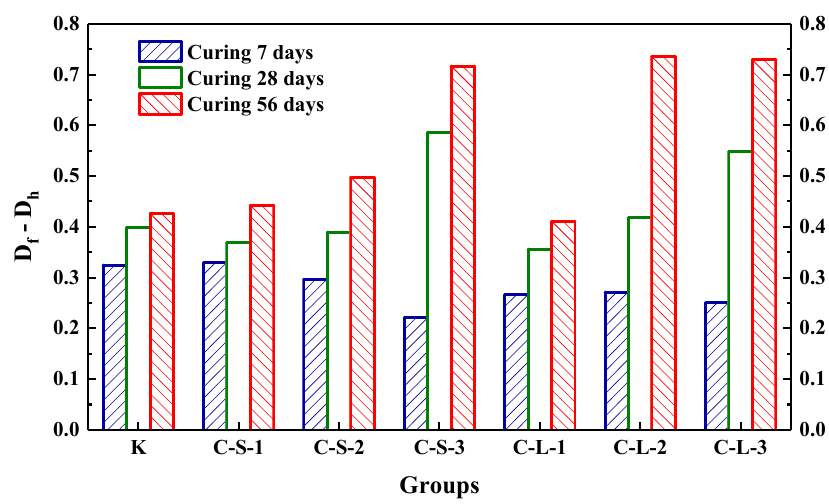
ff erent curing ages.